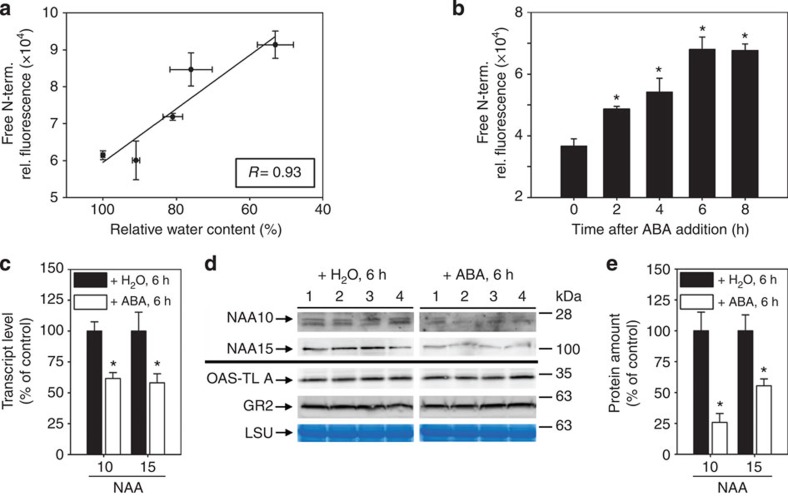
Drought stress and ABA cause significant increase of free N termini.(a) Correlation between free N termini of soluble proteins and the RWC determined in leaves from 6-week-old wild-type plants after application of drought (N=3–5). (b) Quantification of free N termini in soluble proteins extracted from leaf discs of 6-week-old wild-type plants treated with 50 μM ABA for indicated time (N=4). (c) NAA10 and NAA15 transcript steady-state level in the wild-type leaf discs after application of 50 μM ABA for 6 h. (d) Immunological detection of NatA subunits and two cytosolic control proteins (OAS-TL A, GR2) in wild-type leaf discs after application of 50 μM ABA for 6 h. Coomassie-stained RuBisC/O large subunit (LSU) served as loading control. (e) Quantification of NAA10 and NAA15 signal shown in d after normalization to loading control. The amount of NAA10 or NAA15 in wild-type leaf discs treated with water was set to 100% (N=4). Data are represented as mean±s.e. Asterisks indicate significant differences to wild type. (P<0.05, Student's t-test).